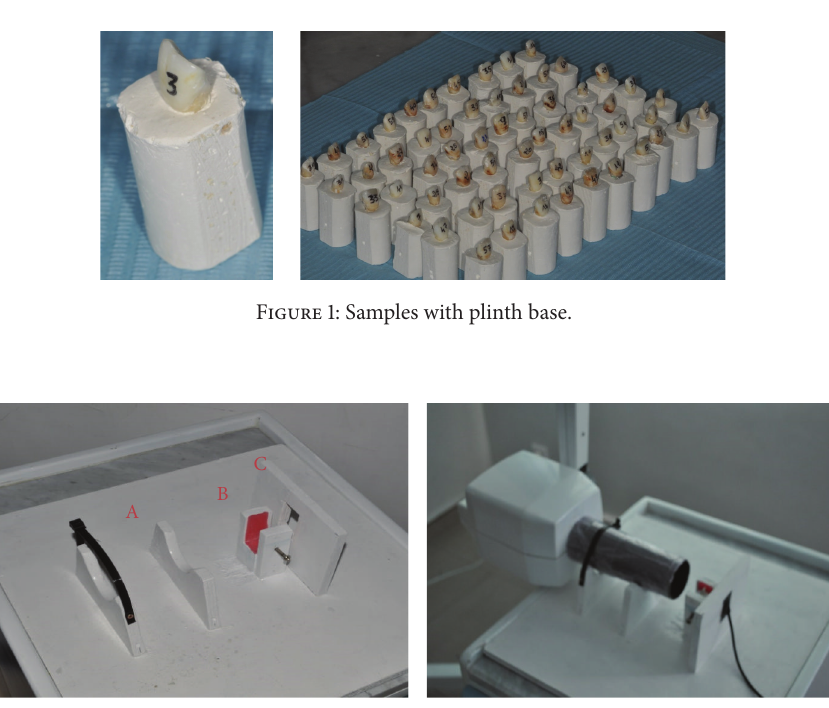
Figure 2: Fixation system. (A) Fixation zone of the radiological cone. (B) Fixation zone of the tooth. (C) Fixation zone of the radiological